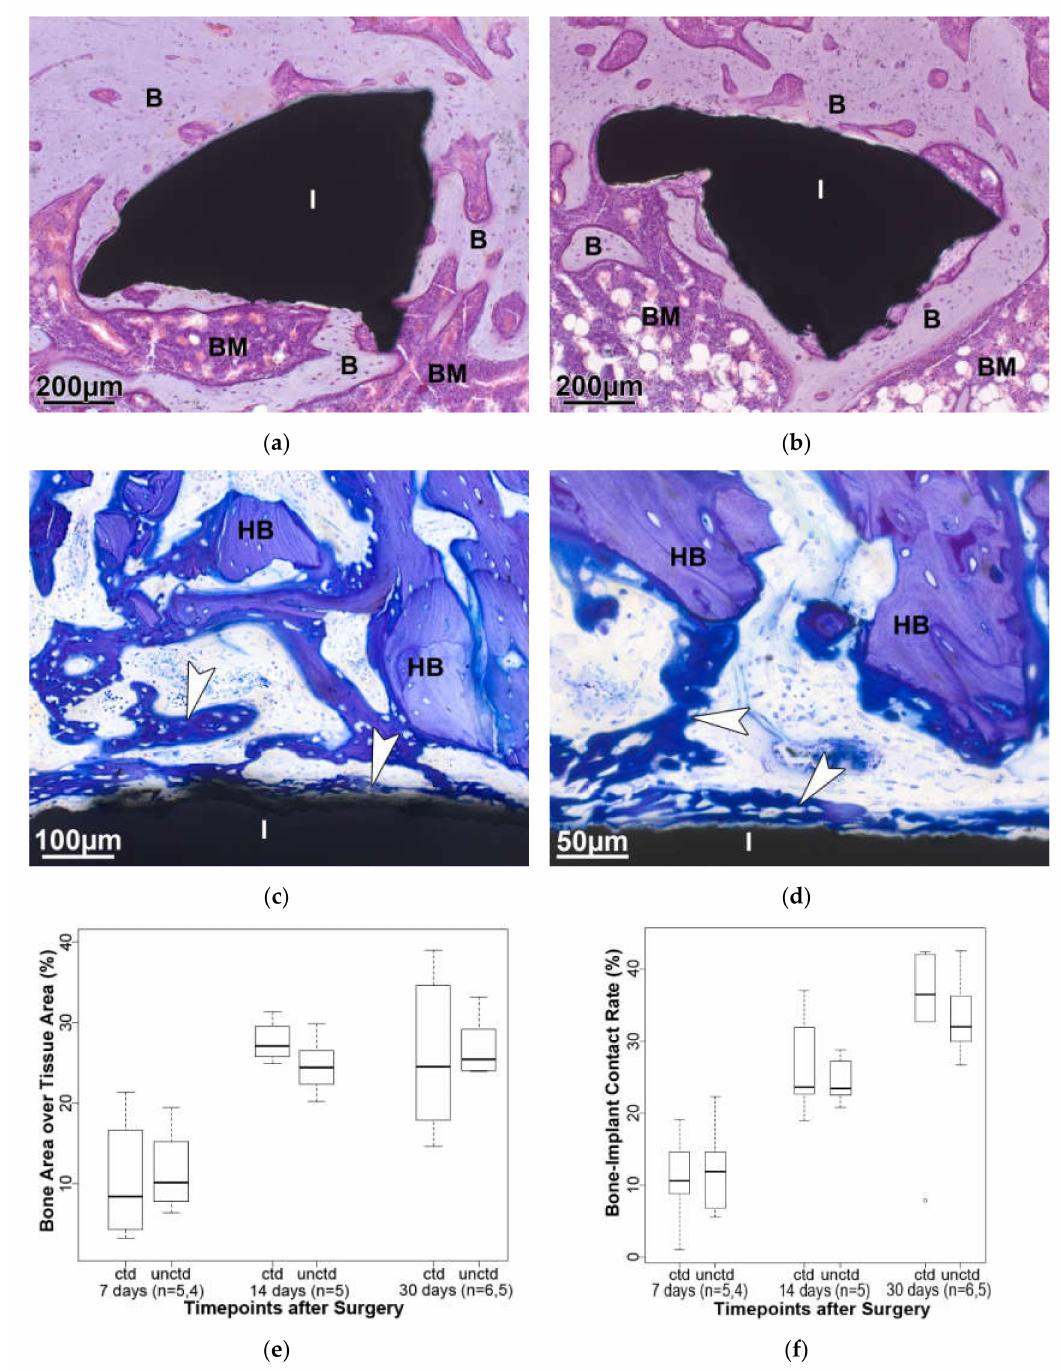
Figure 7. Detailed view of an implant (I) part that is completely consolidated (Hematoxylin-Eosin, 30 days, ( a ) coated, ( b ) uncoated; B—bone and BM—bone marrow). Staining with toluidine blue clearly shows the di ff erence between the host bone (HB) outside the defect zone and the newly formed woven bone (arrowhead) in the interface region between bone and implant; ( c ) coated; ( d ) uncoated, 7 days. ( e ) The bone area over tissue area in the defect area plus 100 µ m increase noticeably between 7 and 14 days after surgery and stagnates afterwards. There are no statistically significant di ff erences between coated and uncoated implants. ( f ) During the healing process, an increase in bone-implant contact is visible, but again there is no statistically significant di ff erence between the implant types. ctd—coated;